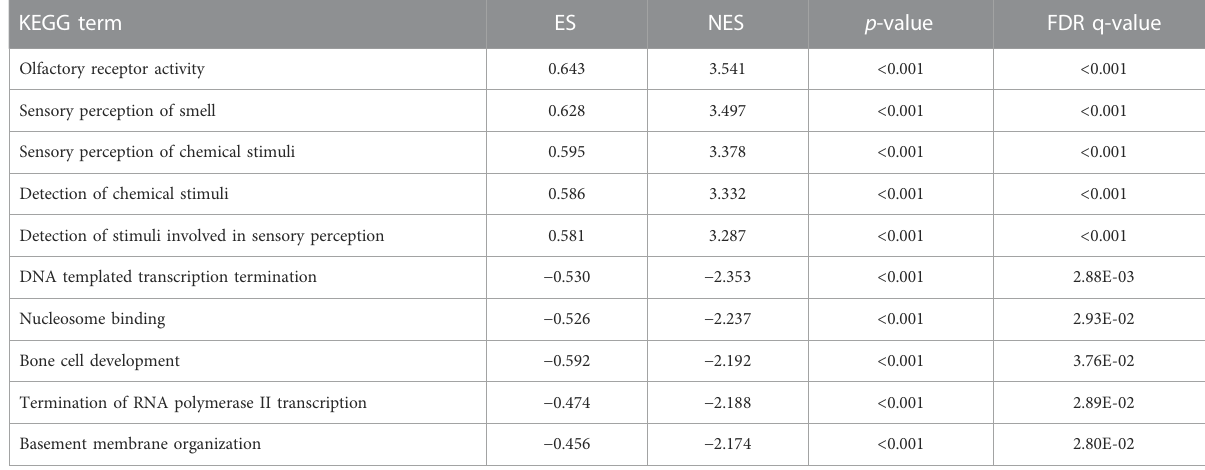
TABLE 5 Top fi ve enriched KEGG terms in the high-risk group and in the low-risk group. KEGG term ES Olfactory receptor